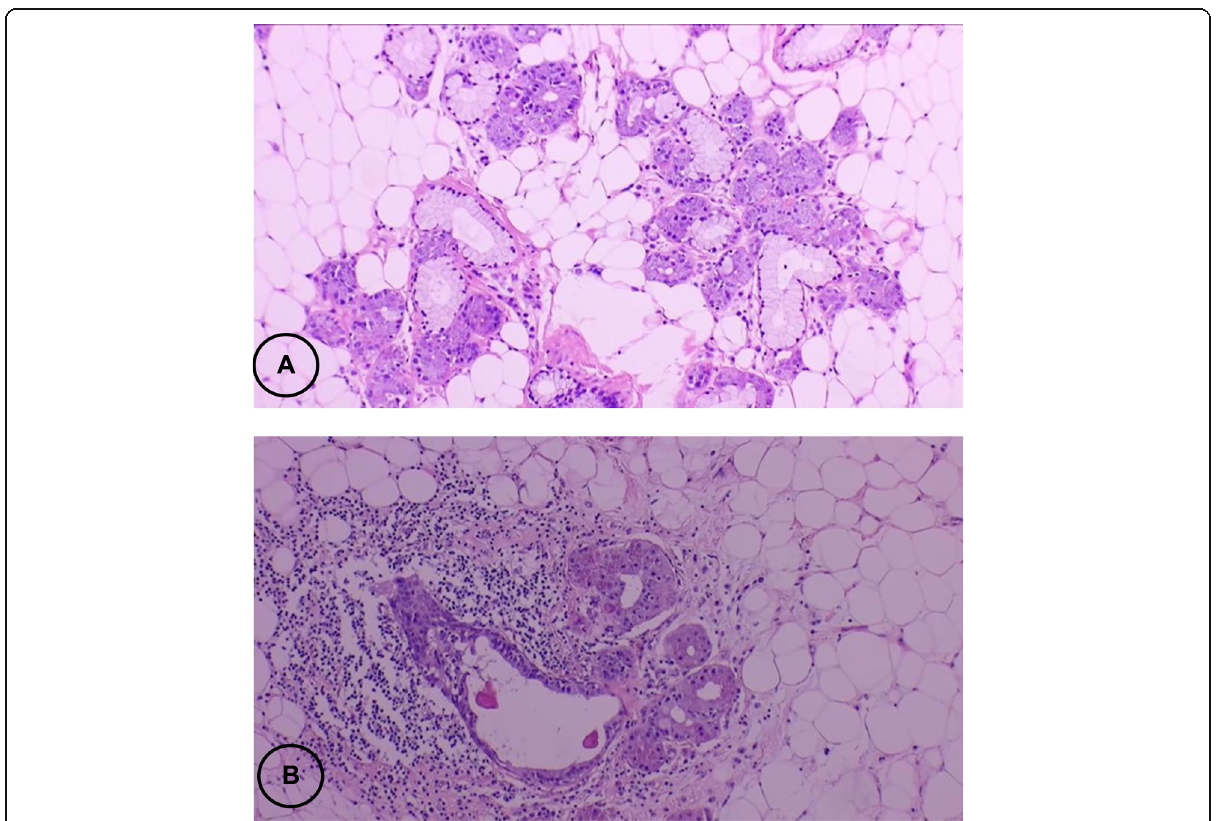
Fig. 5 a A tumour consisting of mature adipose tissue intermingled with uniform epithelial islets of normal duct-acinar units of salivary gland parenchyma type, without any atypia, b Prominent lymphoid infiltrates surrounds the area. (H&E.